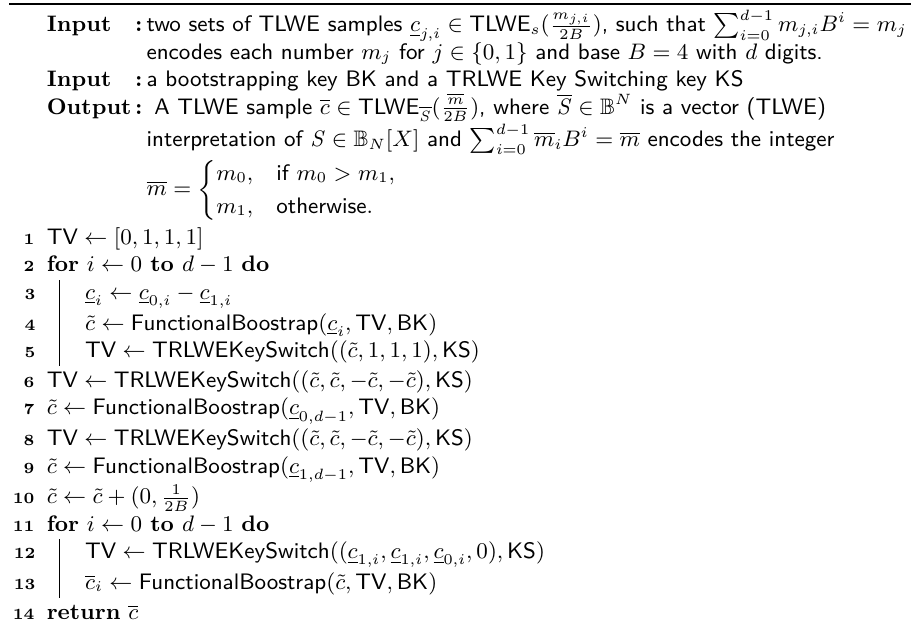
Algorithm 11: Maximum algorithm using the tree-based